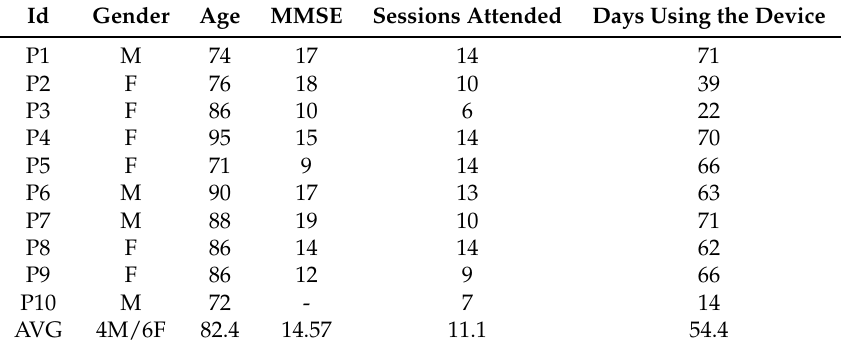
Table 1. Participants in the study.